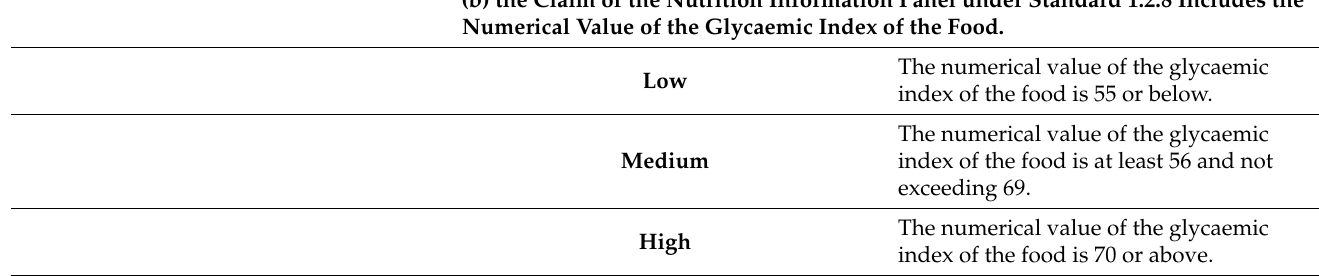
Table 1. Food Standards Australia New Zealand’s Food Standards Code regulations for Glycaemic Index [2].